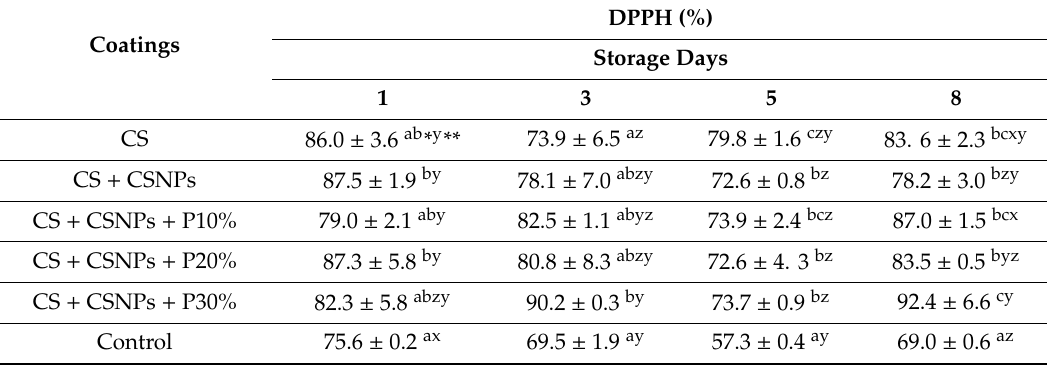
Table 6. Antioxidant capacity of strawberry fruit treated with nanostructured chitosan and propolis coatings during eight days of